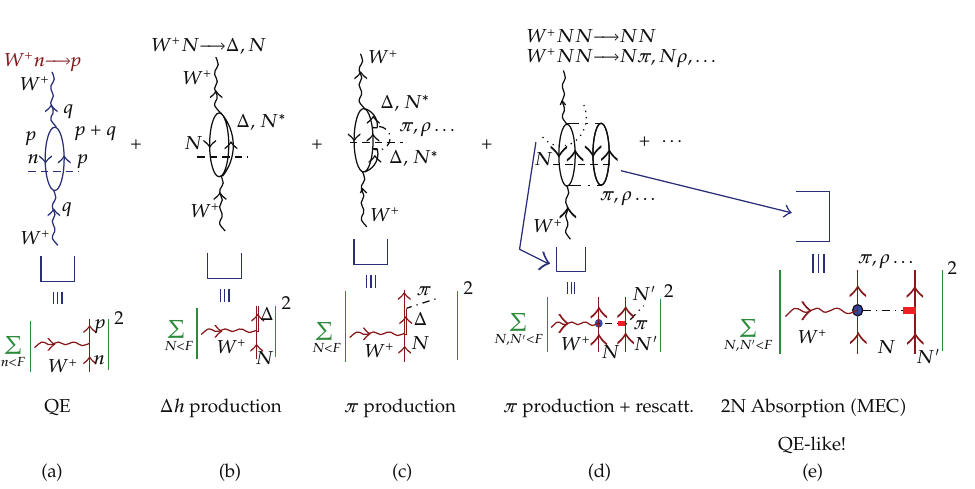
Figure 2: Diagrammatic representation of some diagrams contributing to the W (cid:9) -self energy.